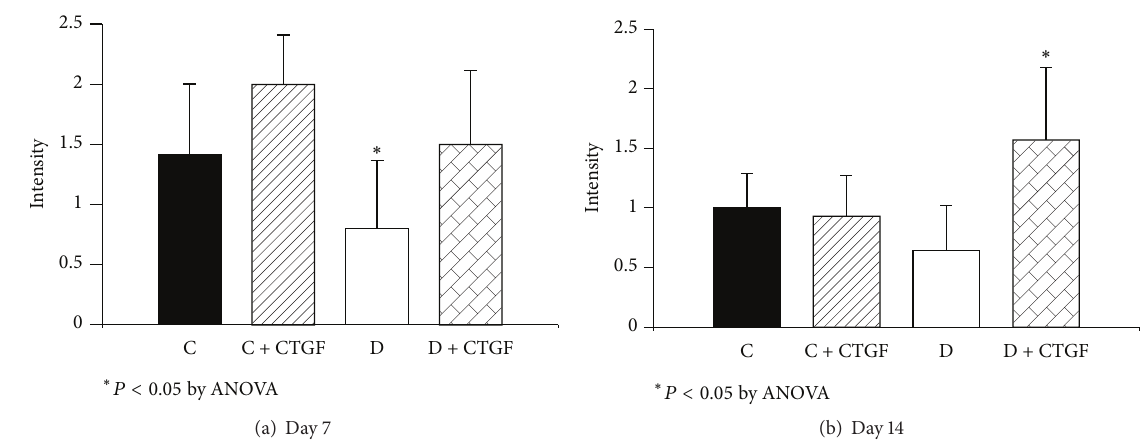
Figure 3: Wound collagen IV staining. (a) shows collagen IV staining was lagging in untreated diabetic wounds at day 7; ∗ 𝑃 < 0.05 compared with Control + CTGF treated animals, by ANOVA. (b) shows at day 14 the CTGF treated diabetic animals showed significantly increased collagen IV compared with the other groups; ∗ 𝑃 < 0.05 by ANOVA. Results are expressed as mean ± SEM.